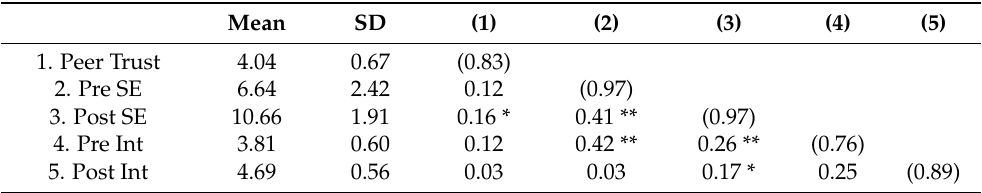
Table 1. Descriptive Statistics and